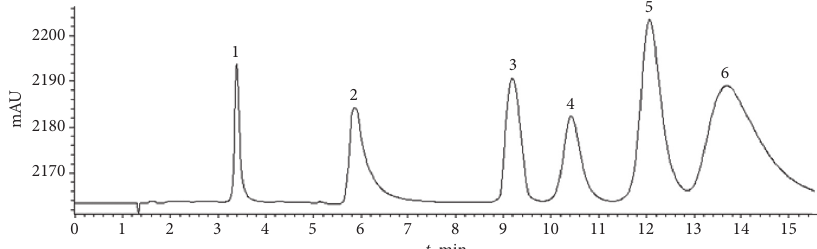
Figure 8: Separation of PA on SP-2 column (80 × 4.6mm). Acids (15 μ g/ml): 1, sorbic; 2, vanillic; 3, sinapic; 4, p -coumaric; 5, caffeic; 6, ferulic.